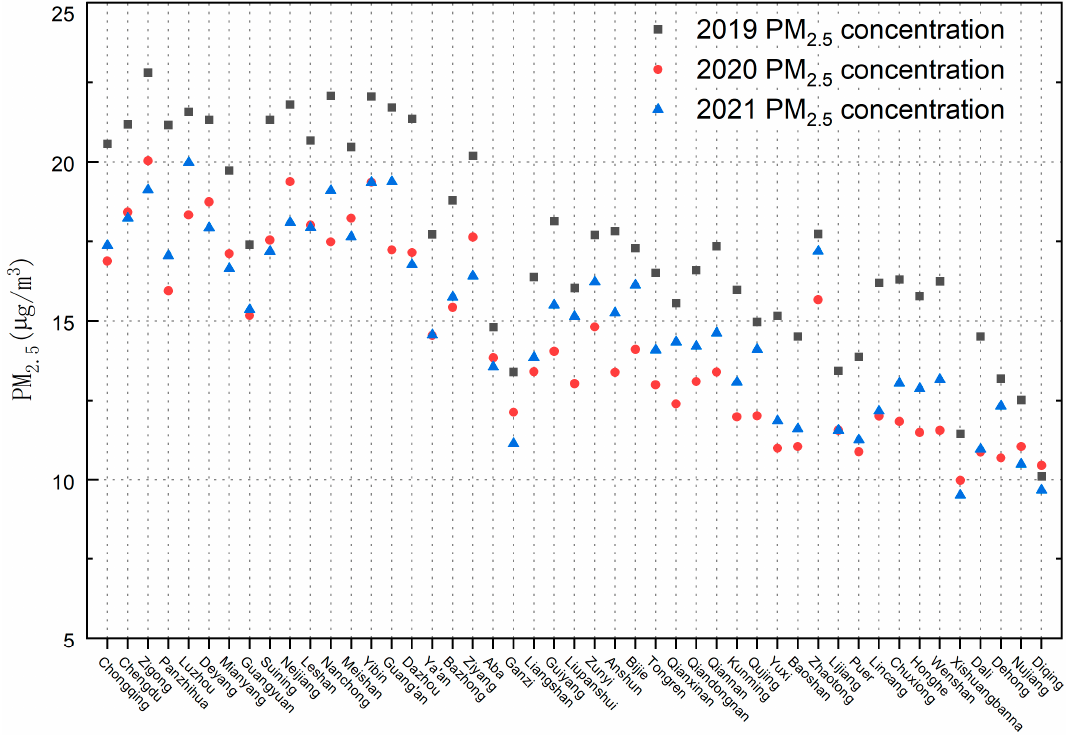
Figure 9. Changes in PM 2.5 concentration in cities of southwest China in summer.